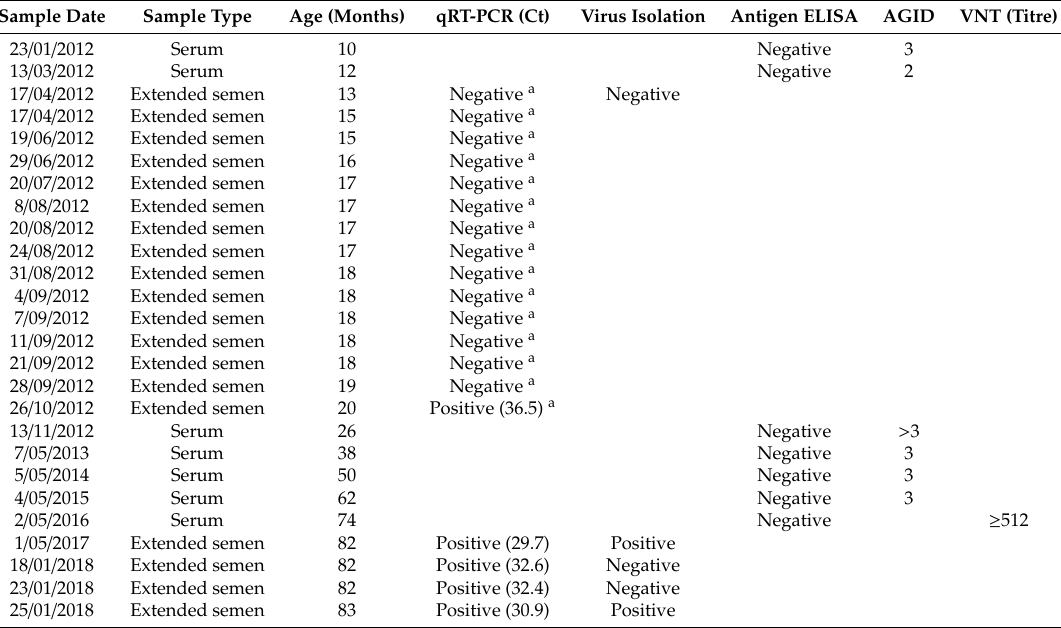
Table A2. Serological and virological test results for Bull